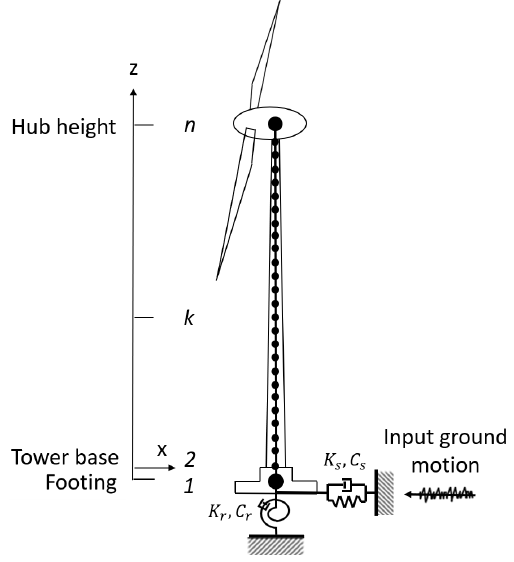
Figure 1. The seismic SSI model for wind turbine support struc-